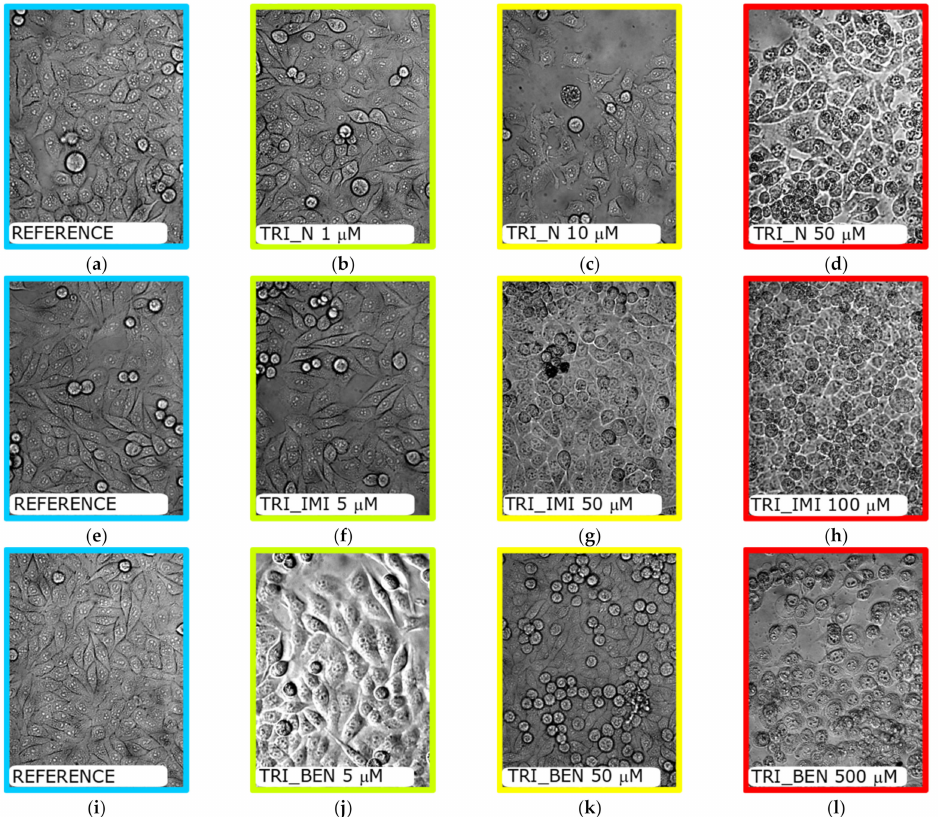
Figure 8. Morphological changes in the HeLa cells after incubation with surfactants at increasing concentrations. Un- treated cells ( a , e , i ), ( b – d ) cells treated with TRI_N at concentrations 1, 10, and 50 µ M; ( f – h ) cells treated with TRI_IMI at concentrations 5, 50, and 100 µ M; ( j – l ) cells treated with TRI_BEN at concentrations 5, 50, and 100 µ M.